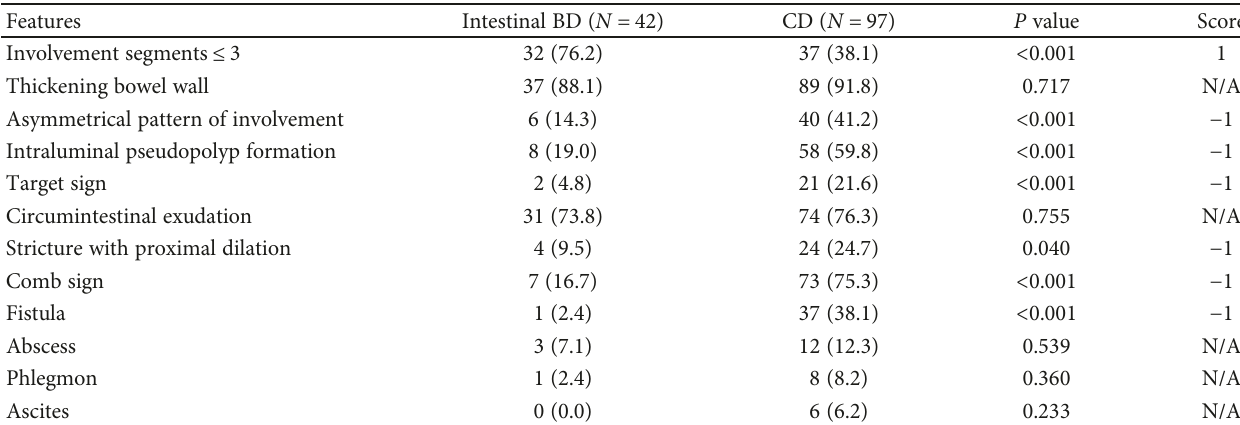
Figure 2: Endoscopic and CTE features in CD: (a) longitudinal ulcer that stretched across several folds under endoscopy; (b) bowel obstruction in the ascending colon due to chronic in fl ammation; (c) perianal fi stula with multiple internal openings; (d) stretching and densifying of distal mesenteric artery the so-called comb sign in the ileum; (e) internal bowel-bowel fi stula the so-called petal sign; (f) asymmetrical thickening of the bowel wall with target sign. Table 3: Radiologic fi ndings of intestinal BD and